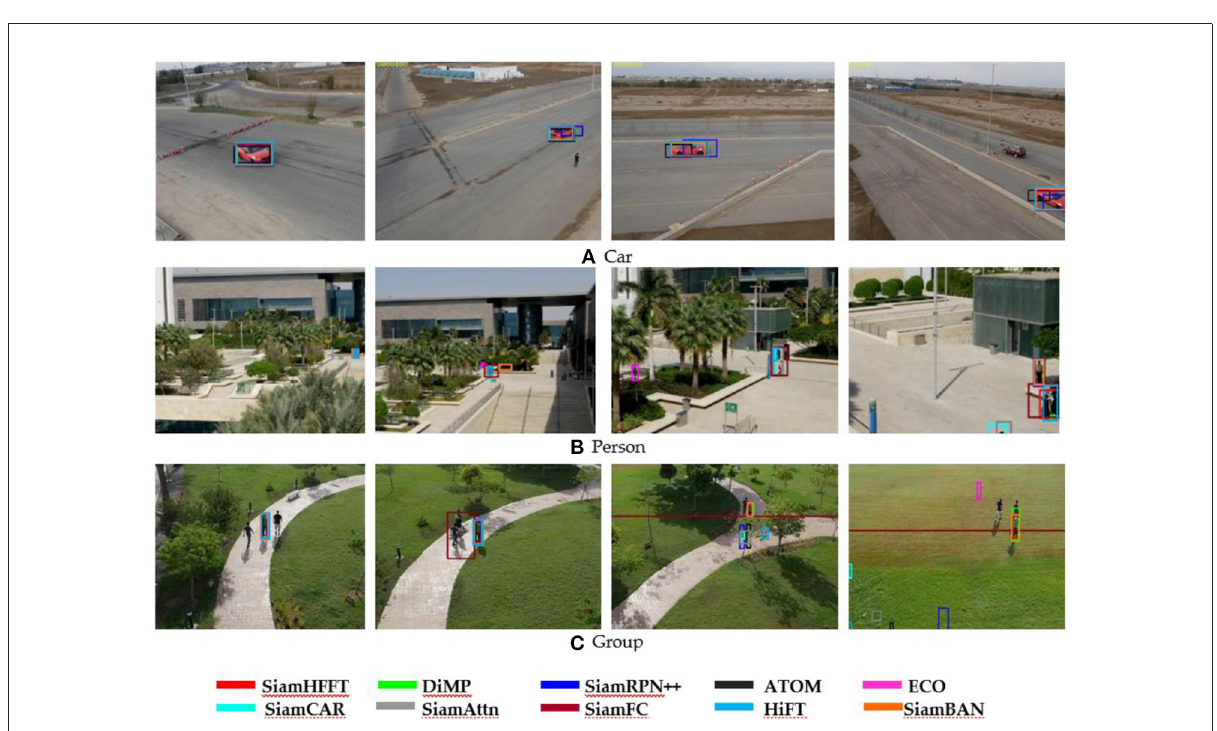
FIGURE6 Qualitative experimental results in several challenging sequences on UAV123 dataset. (A) Video sequences of the Car, (B) video sequences of the Person, and (C) video sequences of the Group.